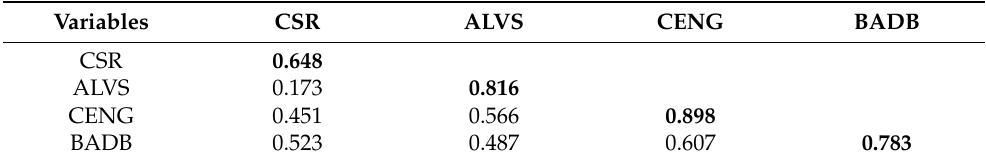
Table 5. Correlations and discriminant validity.